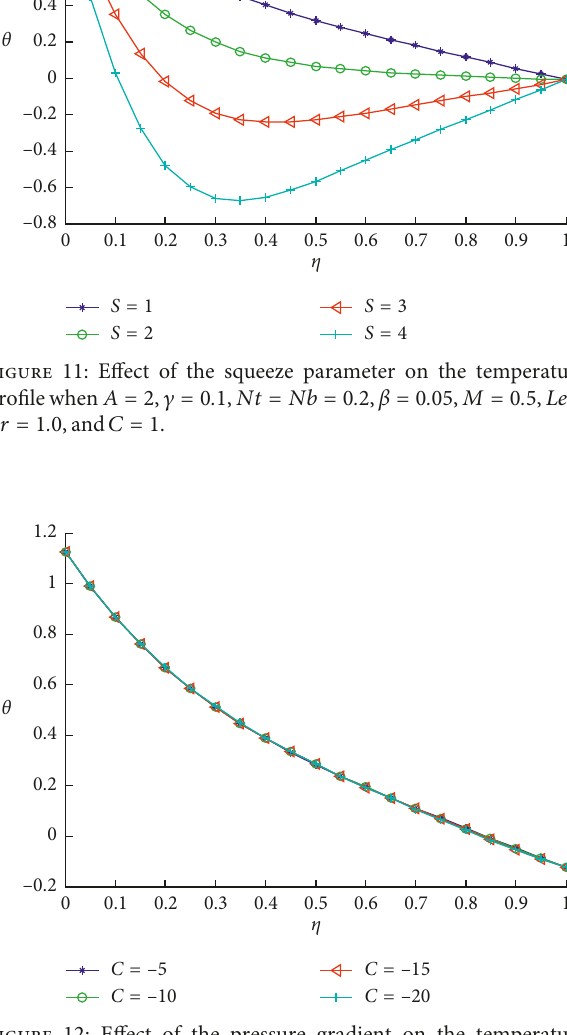
Nb 2 ,S 1 , Nt 0 . 2 , β 0 . 05 ,M (cid:31) (cid:31) (cid:31) (cid:31) (cid:31) 0 . 1. (cid:31)